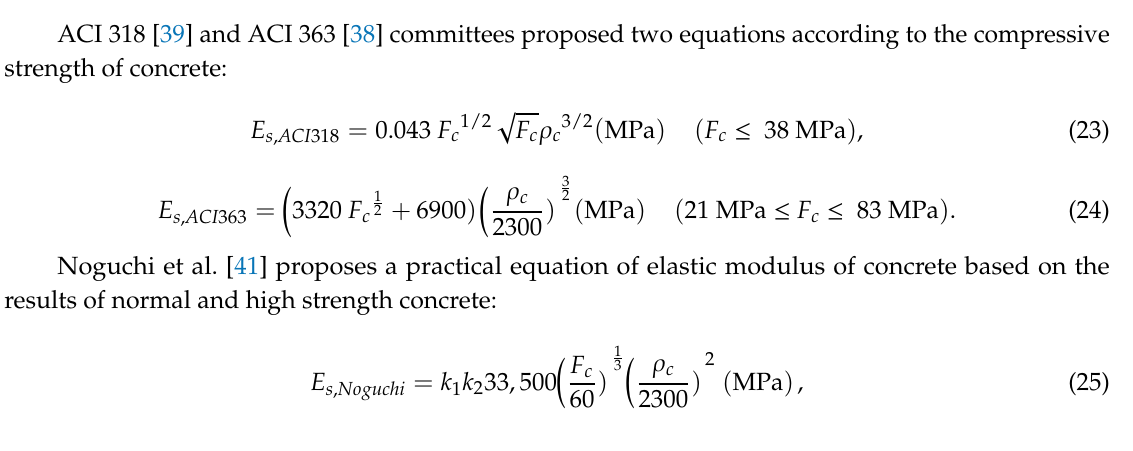
Figure13. Variationofthereductioncoe ffi Figure 13. Variation of the reduction coefficient in the compressive strength of concrete with temperature.